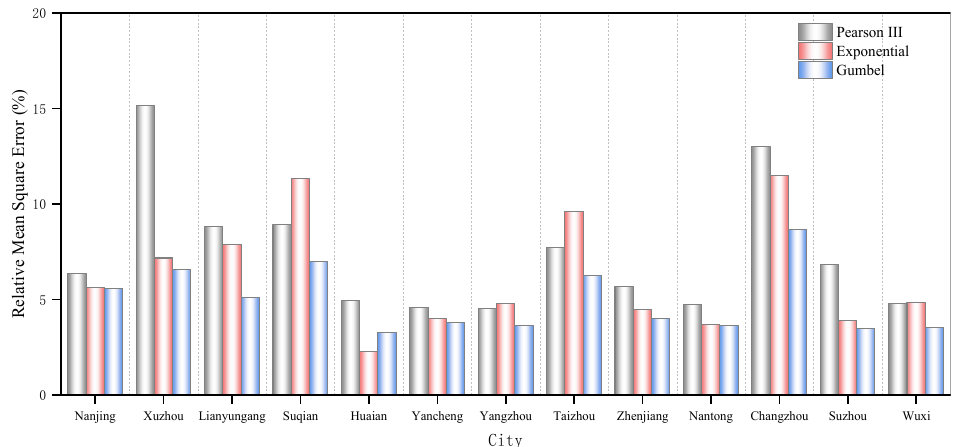
Figure 6. Relative mean square error of three fitting methods for rainstorm intensity.